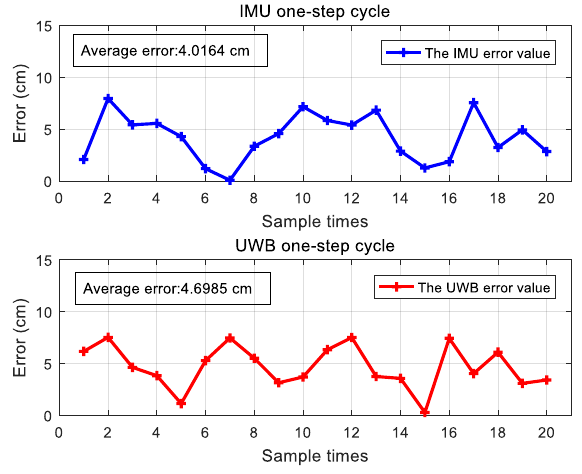
Figure 10. Errors of the 20 repeated walking steps.